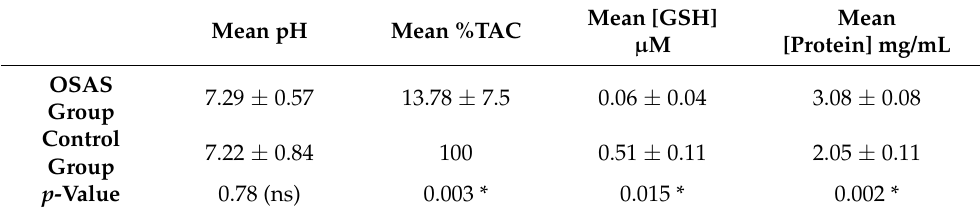
Table 2. Mean value of the biochemical